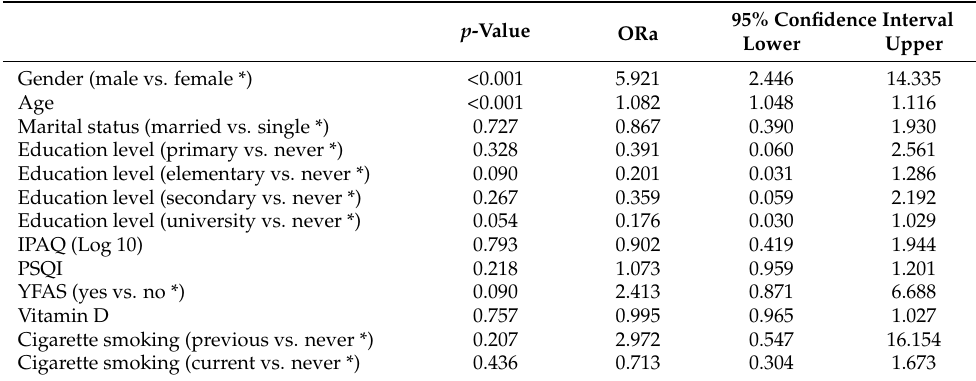
95% Confidence Interval p -Value ORa Lower Upper